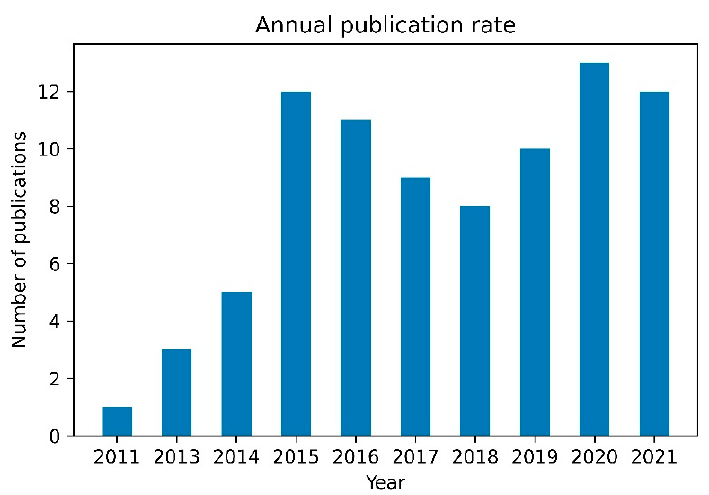
Figure 1. Histogram describing the amount of research works tackling spatio-temporal solar forecasting published from 2011 to 2021.